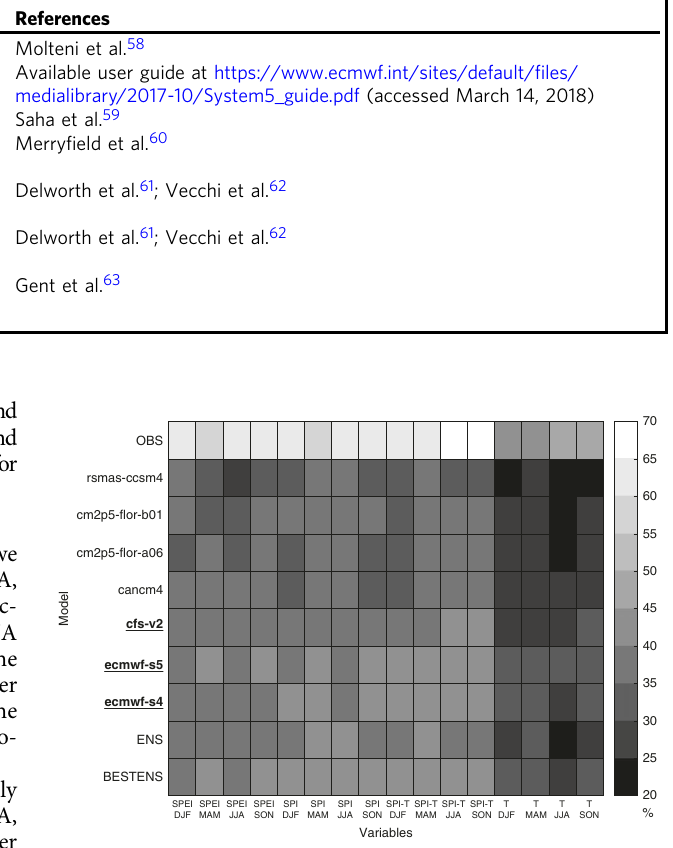
Fig. 4 Percentage of global burnable area with skilful burned area predictions obtained from various seasonal forecast systems. Different rows indicate different climate forecast systems (labelled according to Table 1), including the burned area (BA) predictions obtained with observation (OBS), with the ensemble mean of all the models (ENS), and the ensemble mean of the best models (BESTENS; the best models are highlighted with underlined and bolded name). Different columns indicate the performance of the BA prediction model based on different predictors (SPEI, SPI, SPI and T, and T) for the different